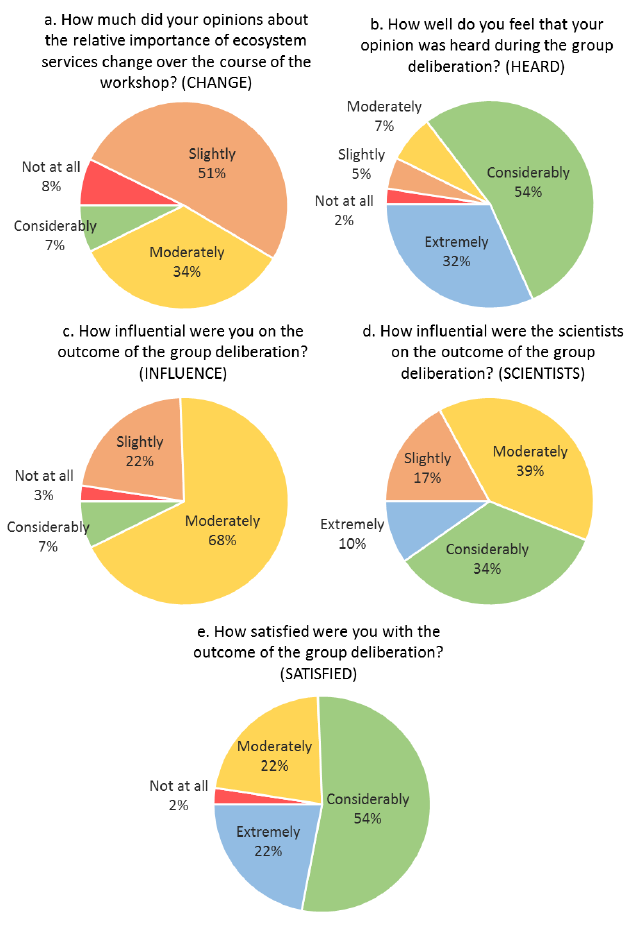
Fig. 4 . Pie charts indicating participant responses to five questions about their experience that were asked after the deliberative